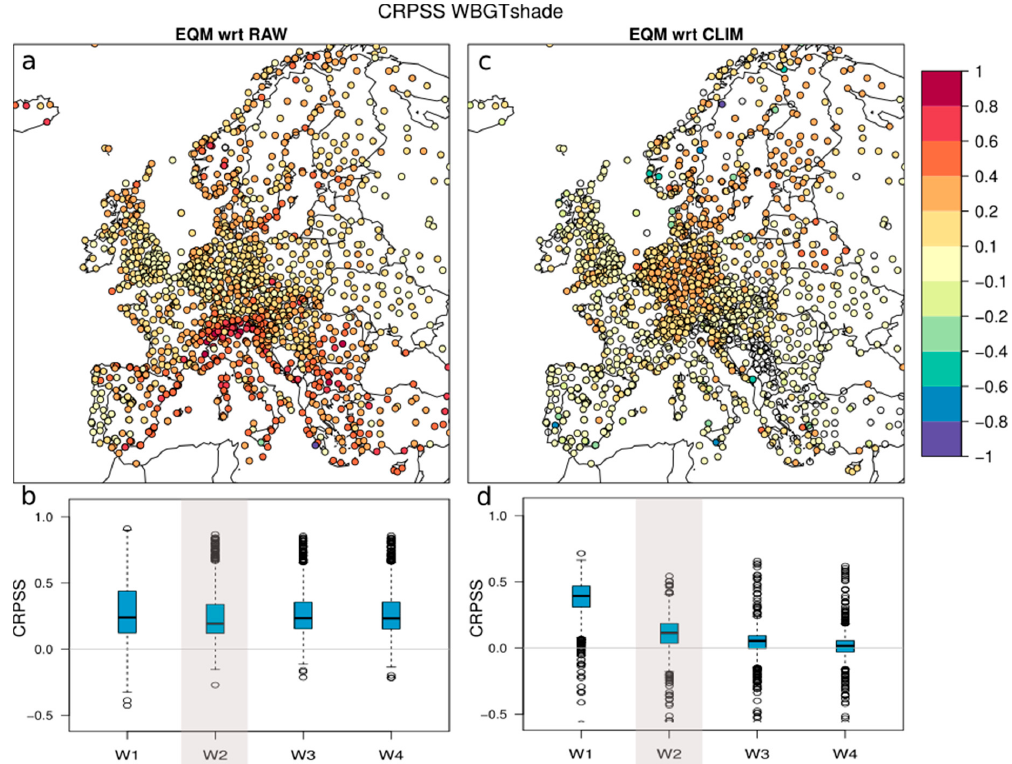
Figure 9. ( a , c ) Maps of skill score (SS) relative to a reference forecast (CRPSS) of WBGT shade at lead times 12–18 days (Week 2 (W2), see details in Section 2.3.3), with respect to the raw forecasts (empirical quantile mapping (EQM) with respect to RAW) and to the climatology forecast (EQM with respect to CLIM). ( b , d ) Weekly CRPSS of WBGT shade . Each box represents the CRPSS values across European stations. The box for W2 (12–18 days) corresponds to the values displayed in the maps above.